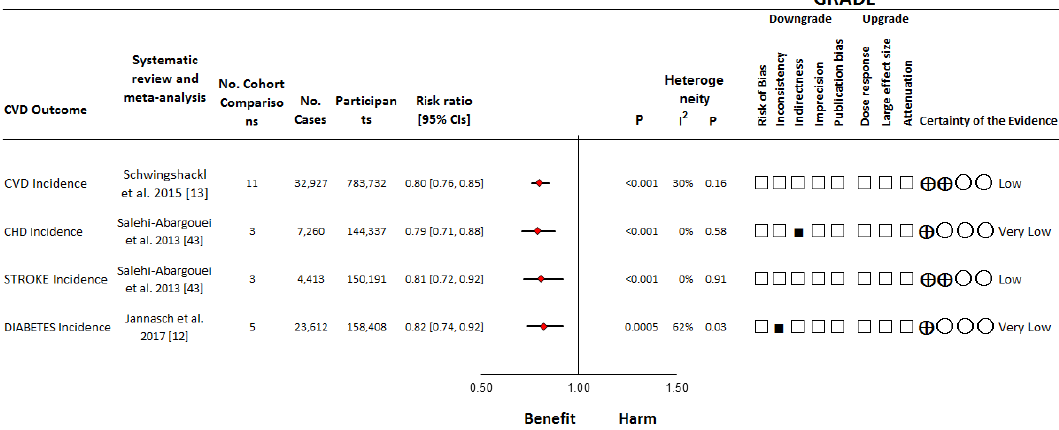
Figure 2. Summary plot of the association between the DASH dietary pattern on risk of various chronic diseases in prospective cohort studies. The pooled risk estimate is represented by the diamond. P-values were determined using random effects modelling in each systematic review and meta-analysis. Between-study heterogeneity was assessed by the Cochran Q statistic, where P < 0.10 is considered statistically significant, and quantified by the I 2 statistic, where I 2 ≥ 50% is considered evidence of substantial heterogeneity [29]. The Grading of Recommendations, Assessment, Development and Evaluation (GRADE) of prospective cohort studies are rated as “Low” certainty of evidence and can be downgraded by five domains and upgraded by three domains. The filled black squares indicate downgrade and/or upgrades for each outcome. CHD = coronary heart disease; CI = confidence interval; CVD = cardiovascular disease; GRADE = Grading of Recommendations, Assessment, Development and Evaluation; NA = not applicable.